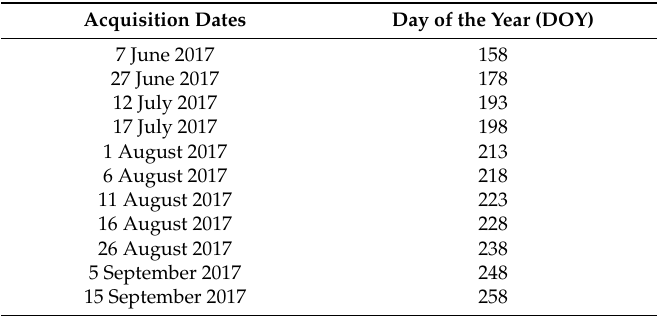
Table 2. Sentinel images used in the